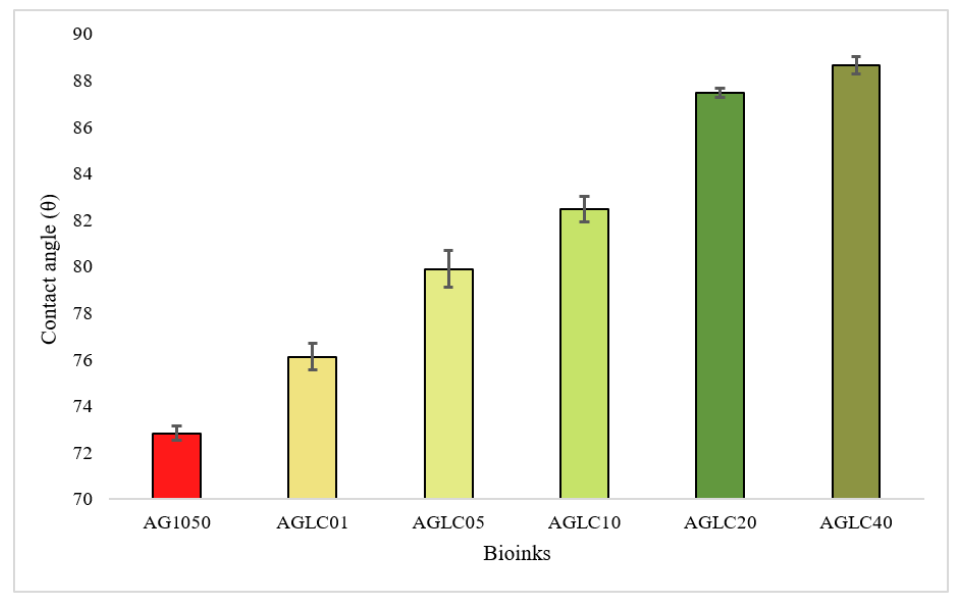
Figure 8. Comparison of contact angle values of AGLC bioinks with varying CELC concentrations.